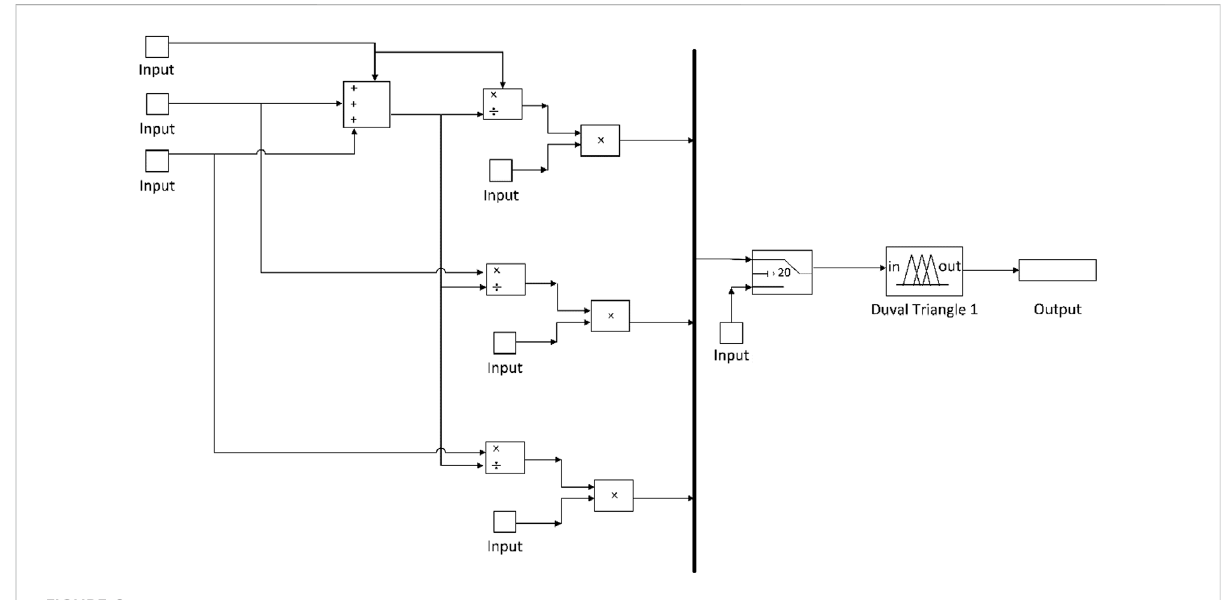
FIGURE 6 Fuzzy sublogic based on Duval triangle